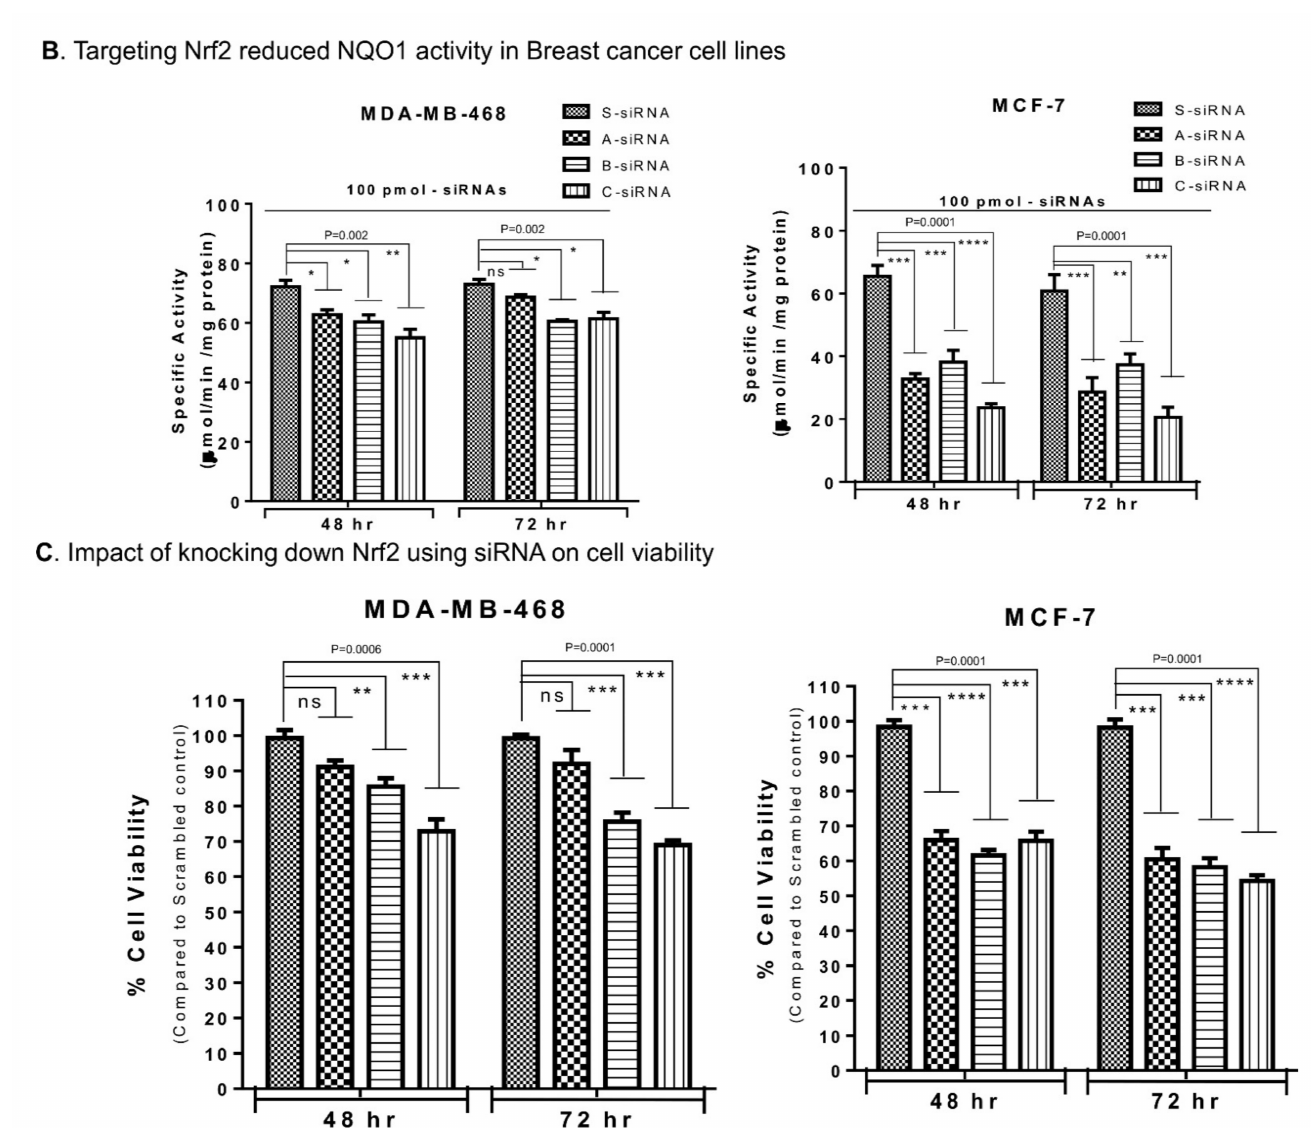
Figure 2. Targeted inhibition of Nrf2 using siRNA in BC cell lines in vitro: ( A ) Nrf2 level was reduced in MCF-7 cells transfected with scrambled siRNA (Control) and three different siRNAs (siNrf2- A , siNrf2- B , and siNrf2- C ) (Supplementary Table S2 shows siRNA sequences). Representative images of immunocytochemistry (ICC) slides are shown (40 × mag- nification, Scale: 50 µ m). ( B ) Reduced NQO1 activity was observed in MDA-MB-468 and MCF-7 cells ( p value = 0.002; p value = 0.0001) with silenced Nrf2. Data were analyzed using one-way ANOVA. ( C ) Cell viability was determined in MDA-MB-468 and MCF-7 cells using MTS 48 and 72 h after siRNA transfection. A significant reduction in cell growth was observed with siRNA-B and siRNA-C in MDA-MB-468 cell line ( p value = 0.0006; p value = 0.0006). In MCF-7 all the three siRNAs yielded significant inhibition of viability ( p value = 0.0001; p value = 0.0001) (* p < 0.05, ** p < 0.01, *** p < 0.005, **** p < 0.001). ns refers to